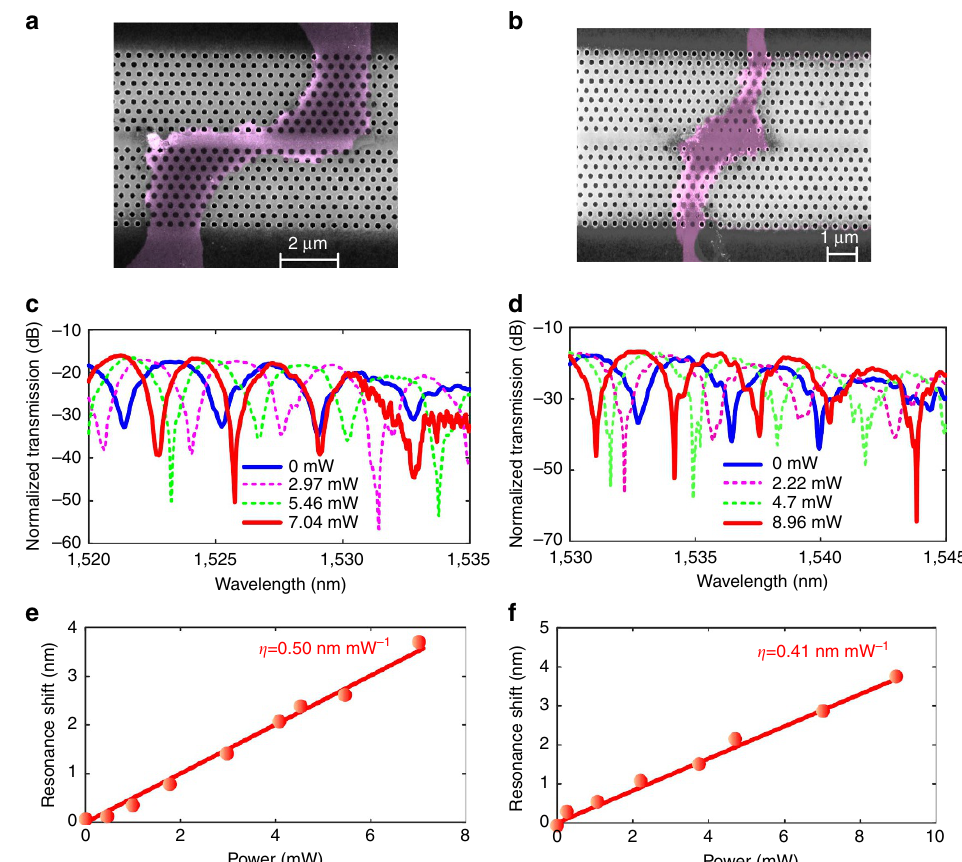
Figure 3 | Characterization of graphene microheater with different graphene–PhCW interaction lengths. ( a , b ) The false-colour scanning electron microscope images of the devices with B 5 and B 3 m m graphene–PhCW interaction lengths, respectively. Transmission spectra at different heating powers for devices with graphene–PhCW interaction lengths of ( c ) B 5 m m and ( d ) B 3 m m. ( e , f ) Corresponding shifts of the transmission spectra as a function of the heating